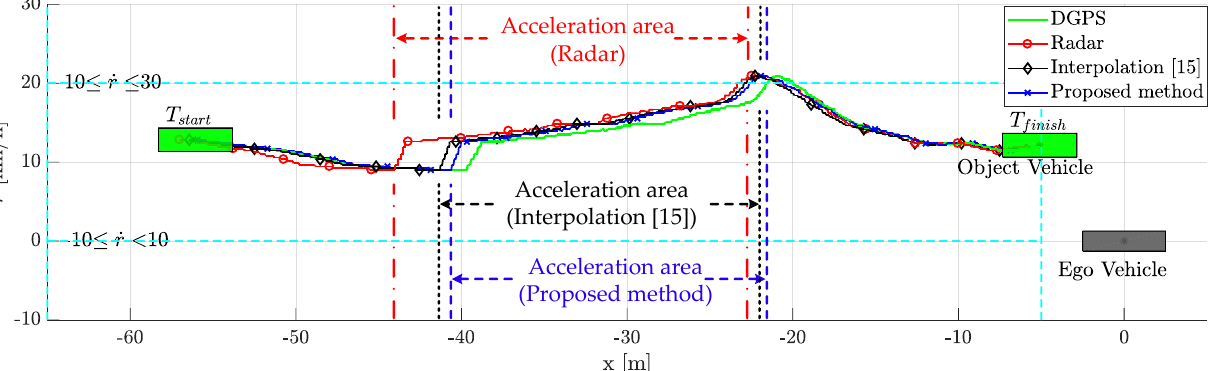
Figure 10. Scenario-based relative movement for relative longitudinal distance and relative speed replotted from Figure 9: there is an acceleration area because the object vehicle changes lanes with increasing speed to overtake the ego vehicle. After that, the relative speed decreases.